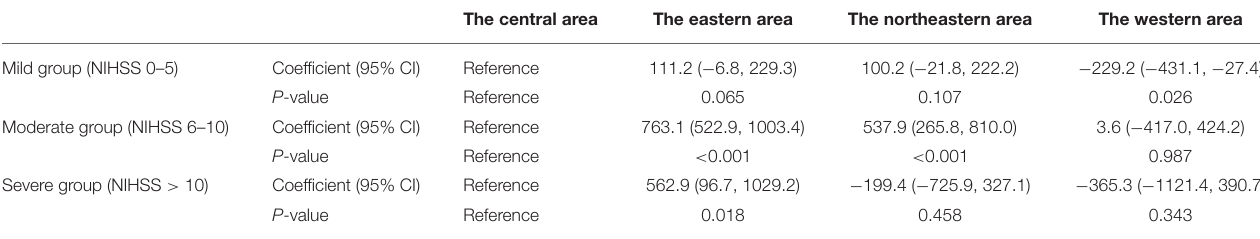
TABLE 3 | Association between regions and total hospital costs in different stroke severity groups.